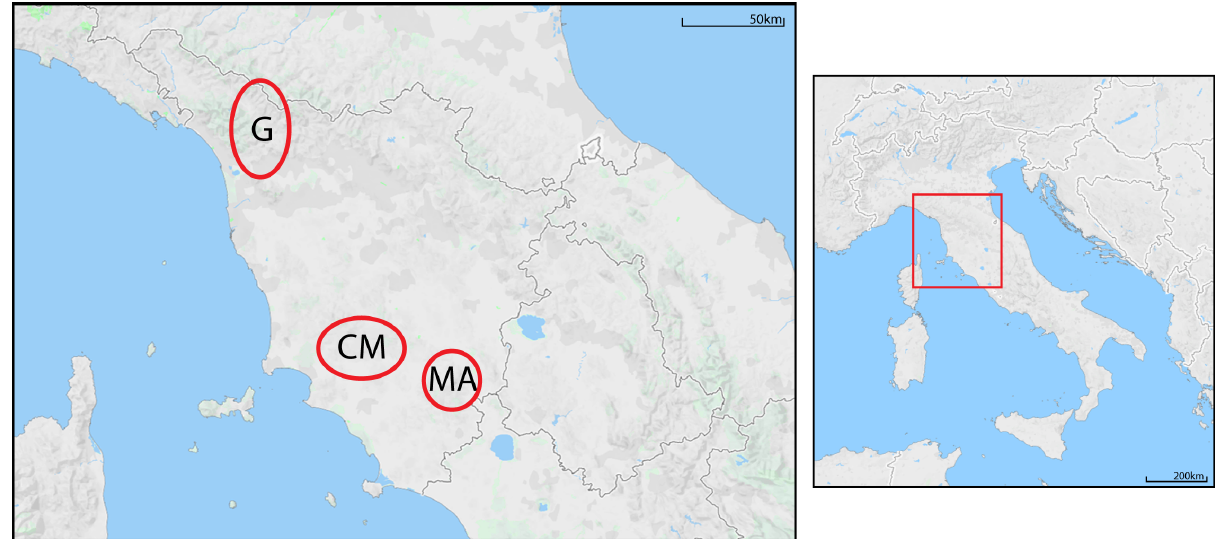
Figure 1. Location of the study area (Tuscany, Italy) and spatial distribution of the population nuclei. G = Garfagnana; CM = Colline Metallifere; MA = Monte